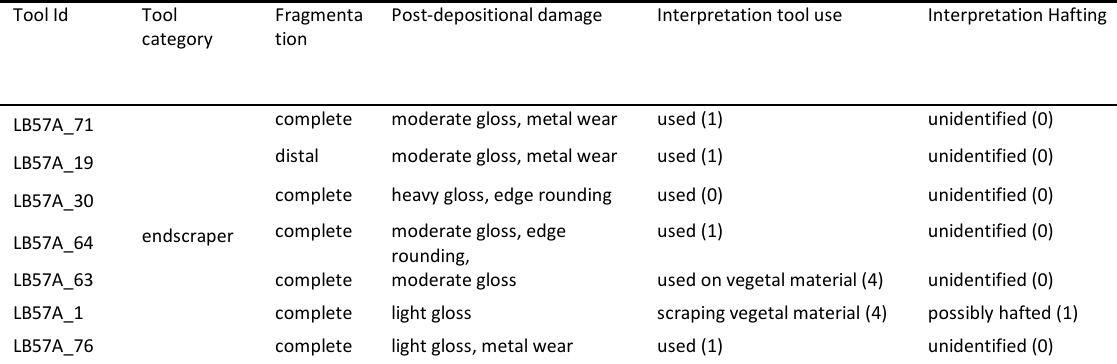
Table 7. Overview of the seven endscrapers from locus LB57a with use-wear evidence (Scale of certainty related to the interpretation: uncertain (0) poor certainty (1); moderate certainty (2); high certainty (3); certain